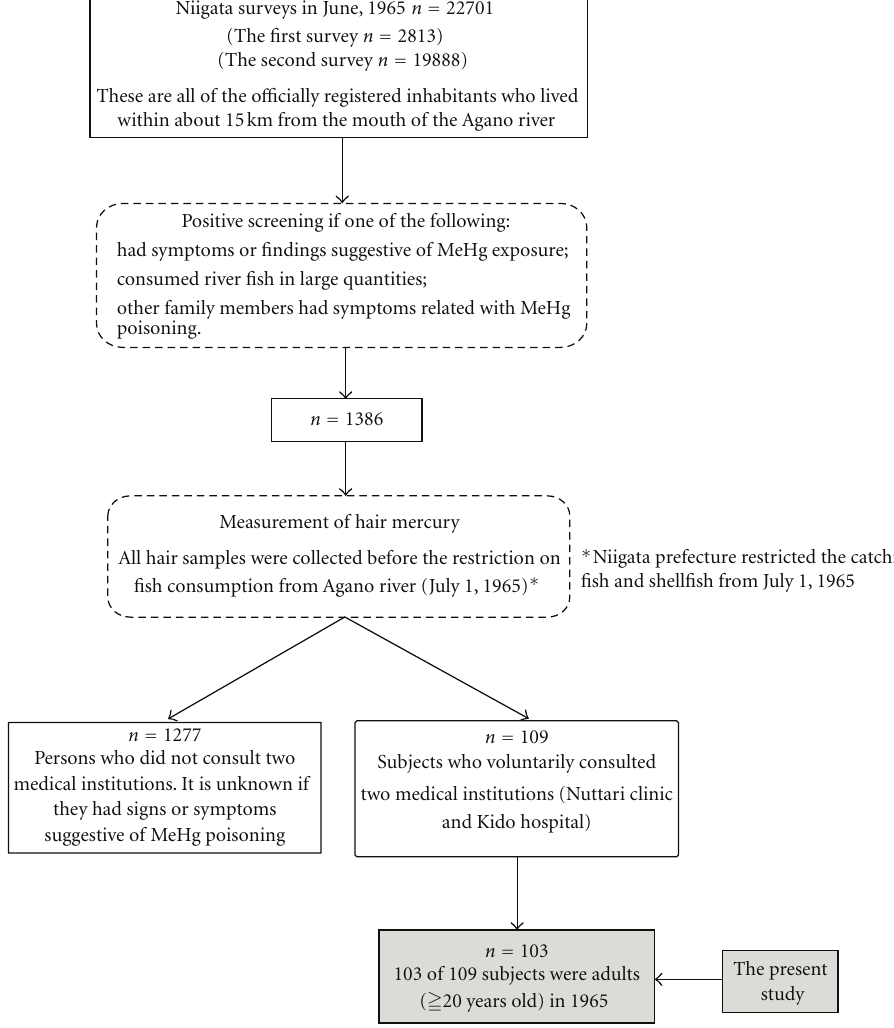
Figure 1: Sampling process of the study